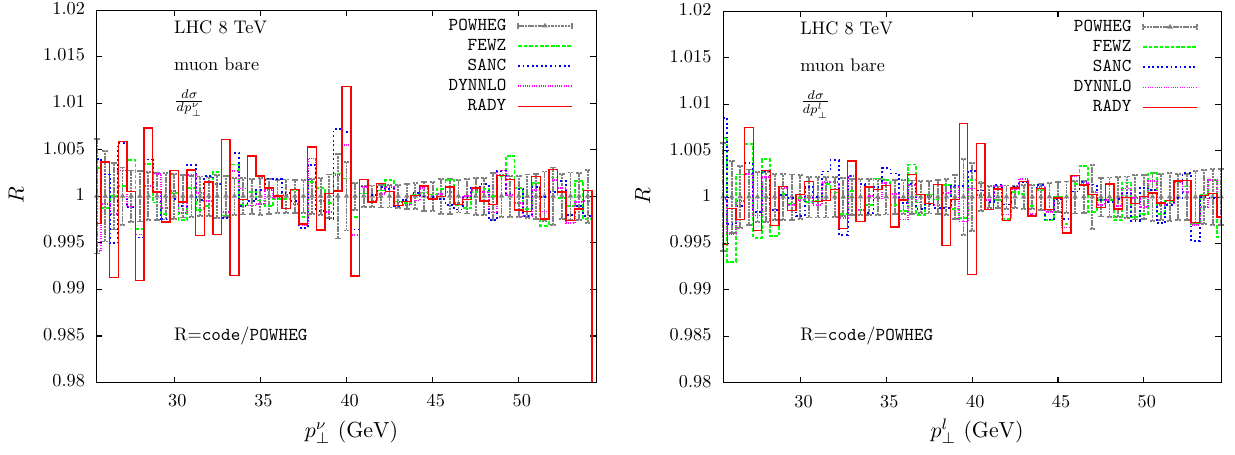
Fig. 6 Tuned comparison of the muon and muon neutrino transverse momentum distributions in pp → W + → μ + ν μ + X at the 8 TeV LHC with ATLAS/CMS cuts in the bare setup, including NLO QCD